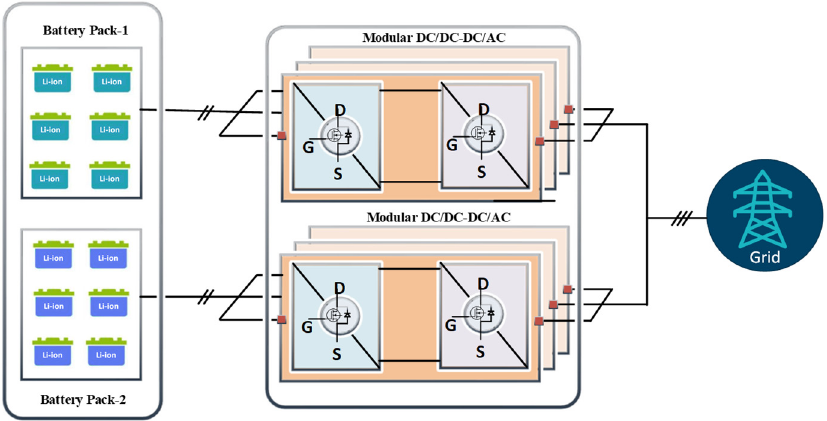
Figure 2. PE configuration 1: only PCS-1 is used.